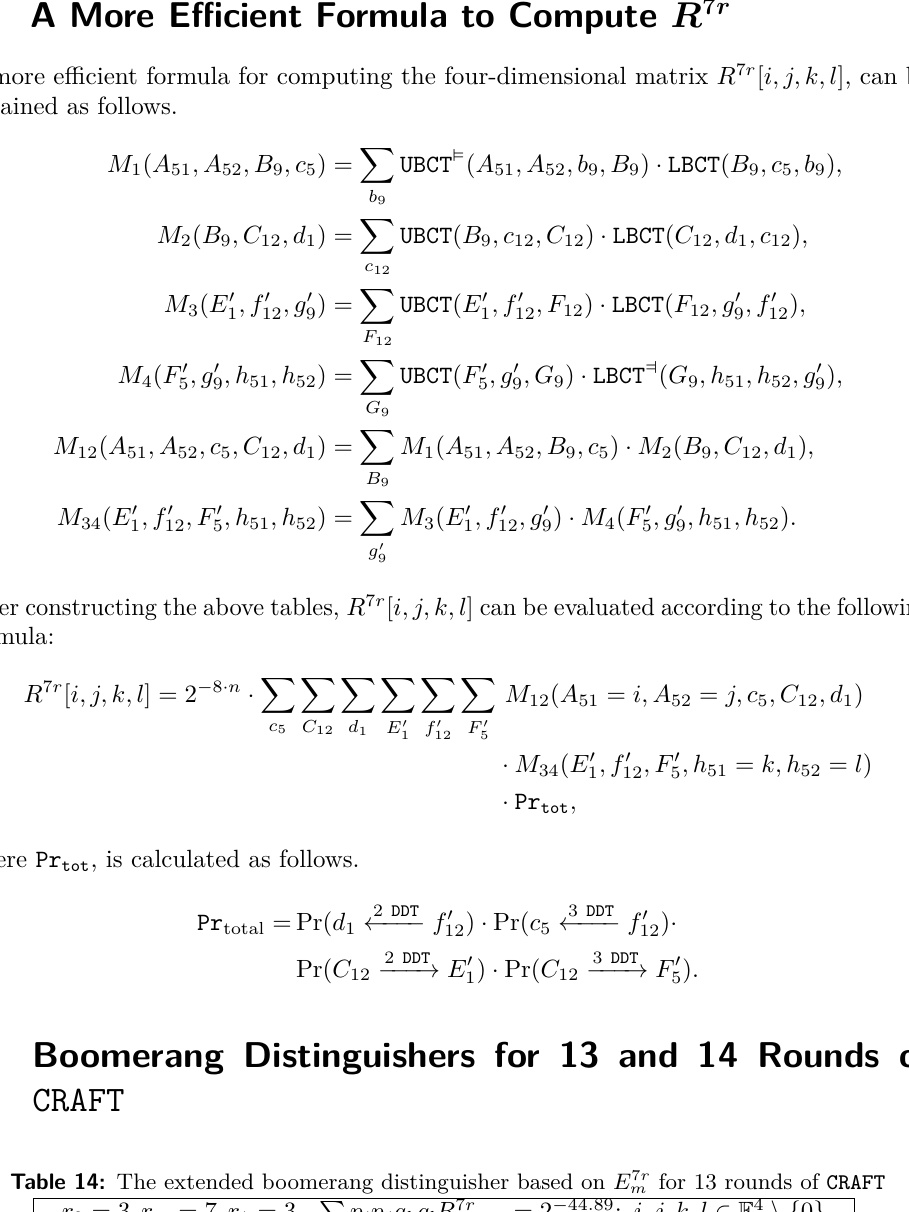
\ { 0 = 2 − 44 . 89 ; i, j, k, l ∈ F 4 2 i,j,k,l